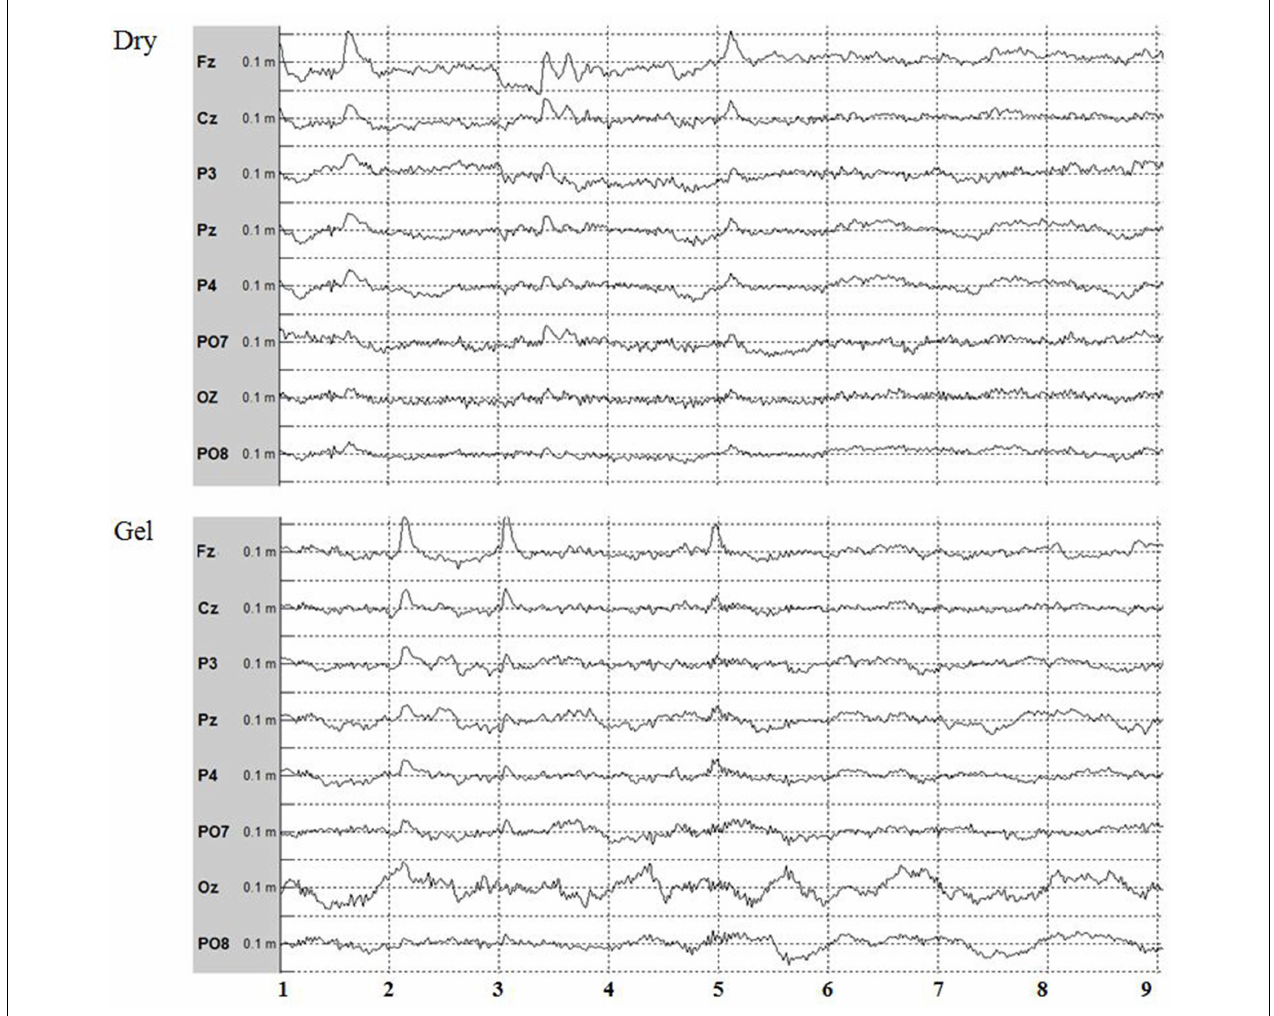
FIGURE 3 | Eight-channel EEG data from the P300 experiment acquired with dry and gel electrodes for one subject over frontal, central, parietal, and occipital sites. The EOG artifacts are mostly visible on Fz, Cz, P3, Pz, and